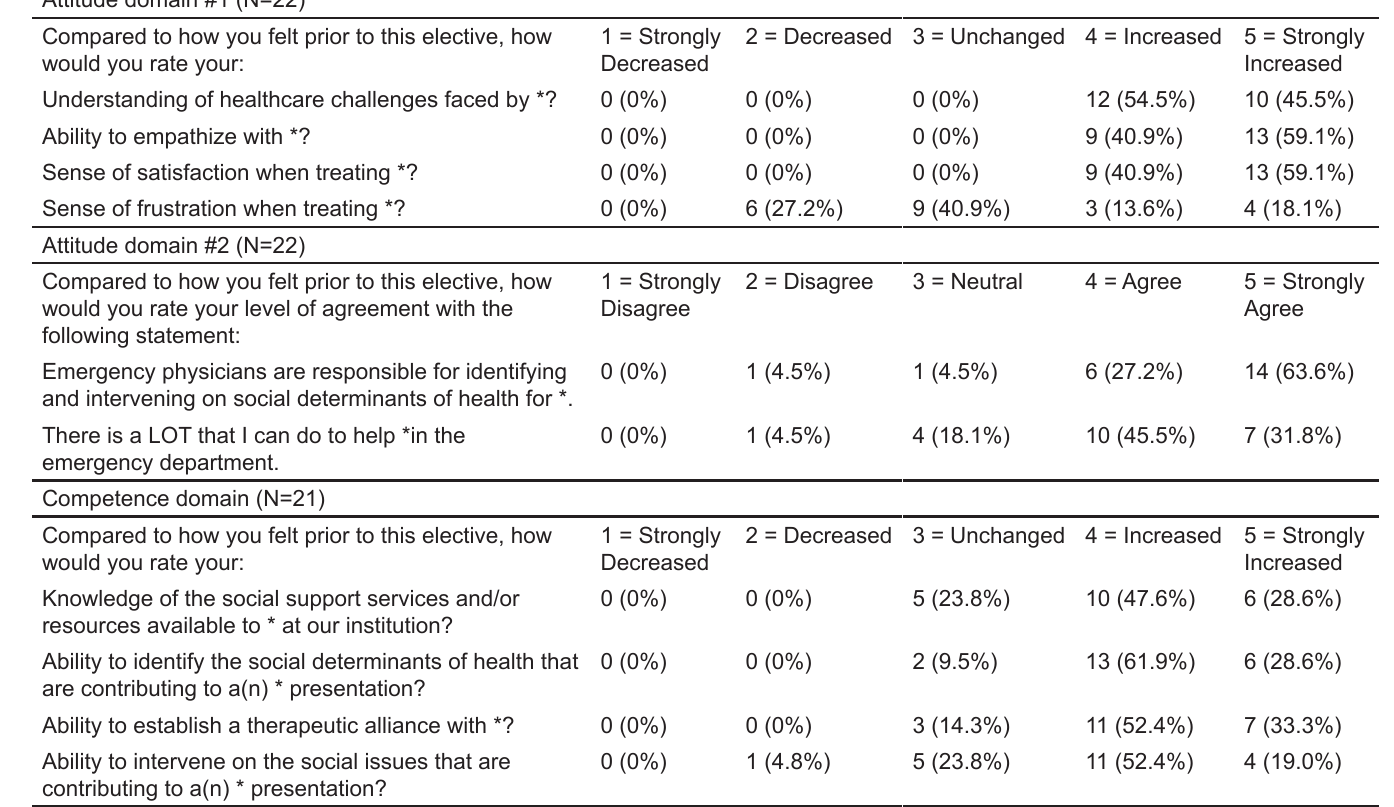
Table 2a. Aggregate post-elective experience survey scores by domain. Attitude domain #1